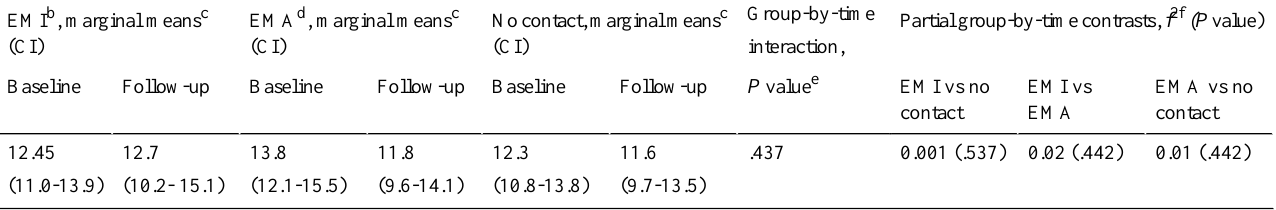
Table 2. Log peak risky single-occasion drinking (RSOD) at baseline and follow-up by study group: marginal geometric means for number of drinks consumed in most recent heavy drinking occasion, P value for group by time interaction, and partial group by time contrasts (standardized effect size [Cohen f 2 ] and P value) from random effects linear mixed modeling a (n=265).